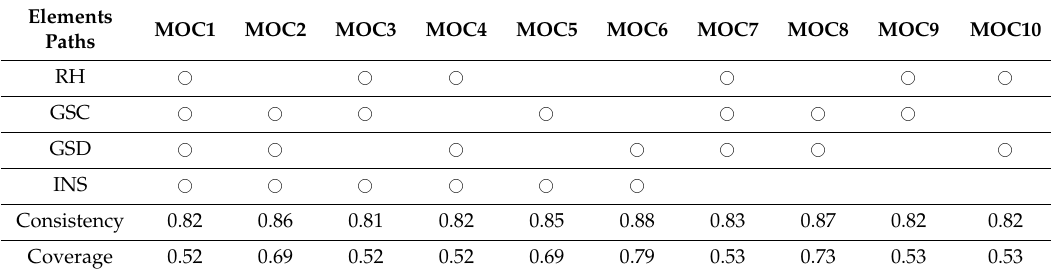
Table 7. Analysis of combinations of causal conditions of MOC.